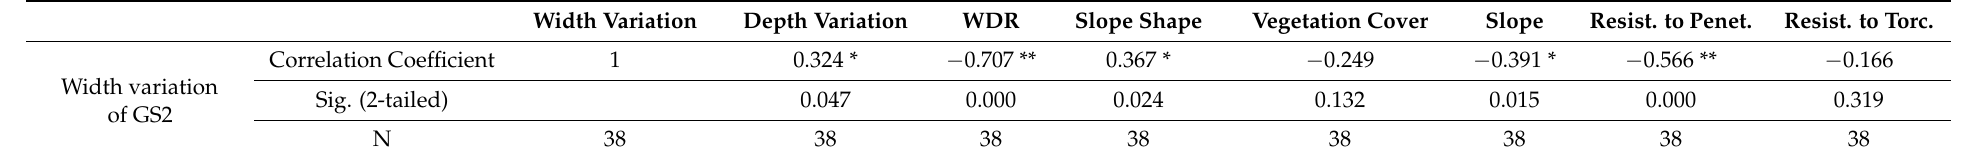
Table 3. Correlation between the variables considered and widening of gully section